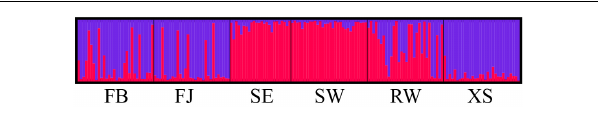
FIGURE 4 | Genetic structure revealed by the Bayesian model-based analysis using STRUCTURE 2.3.4 for farmed and spontaneous populations of Saccharina japonica from a kelp farm in China. Each individual is indicated by a vertical colored bar, and the proportion of the color in each bar represents the probability of membership in the corresponding cluster.